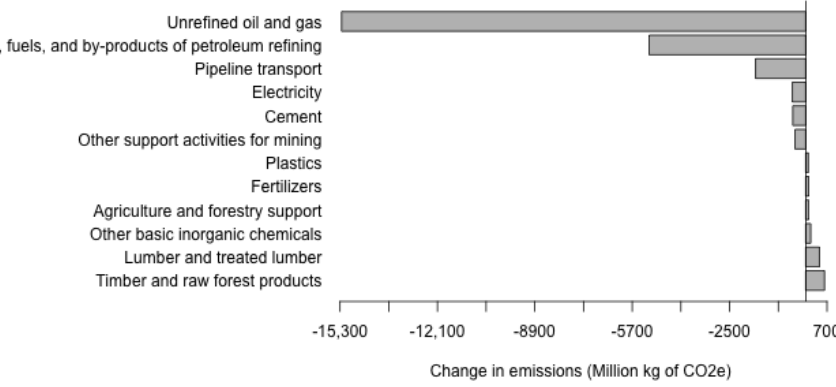
Figure 3. Changes in overall commodity GHG contributions. The top six commodities with the great- est increases in GHGs and top six commodities with the greatest decreases in GHGs are